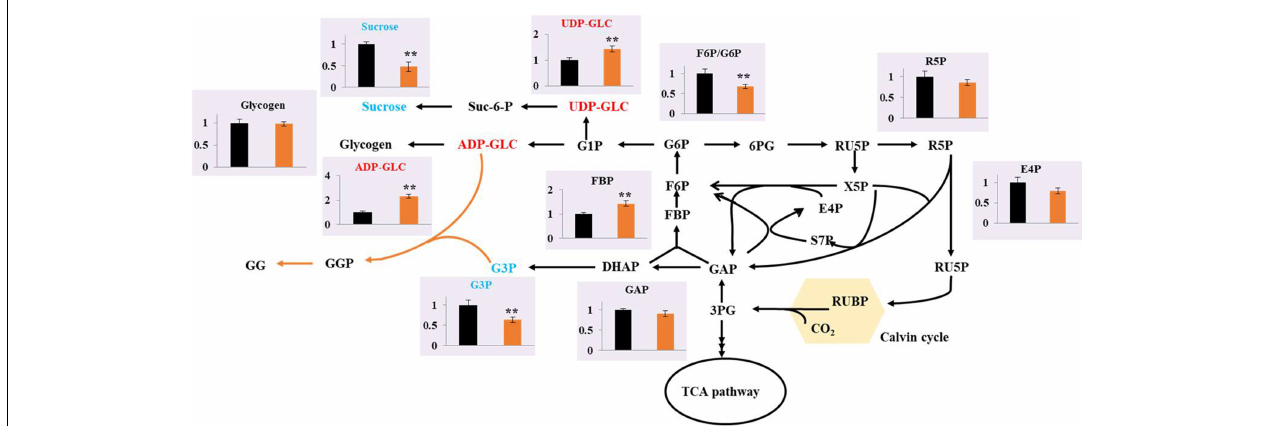
FIGURE 3 | Comparison of the metabolites between the strains M-pSI (black) and M-GgpPS (orange) under 0.4 M NaCl. The y -axis is the ratio of the abundance of strain M-GgpPS to strain M-pSI under 0.4 M NaCl. The average value for strain M-pSI was set to 1. Data show the mean with error bars indicating the standard deviation calculated from three independent biological